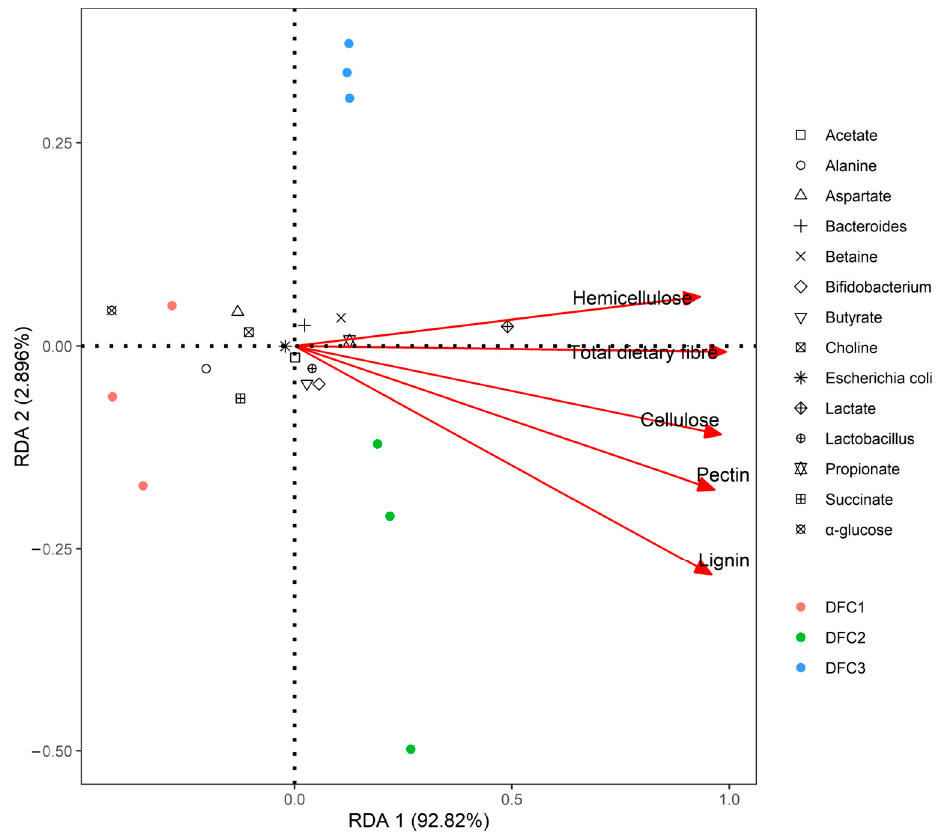
Figure 7. Redundancy analysis between the fiber content of different DFCs and metabolites and gut microbes.